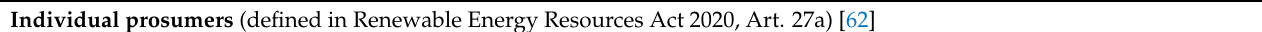
Table 4. Current renewable capacity additions by Polish citizens. Type of activity, estimates, motiva- tions, and identified barriers from the database and interviews